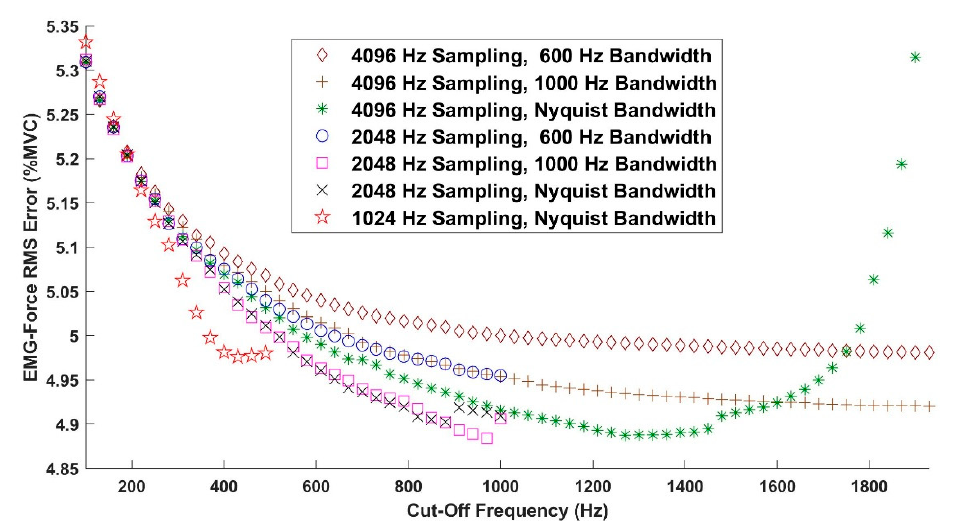
Figure 4. Mean EMG-force error results for first-order Butterworth high-pass filter whitening, as a function of high-pass filter cut-off frequency, for all processors including RDS processing. Standard deviations (not shown) each ranged from 2.04 to 2.58% MVC. Results without RDS processing were similar.